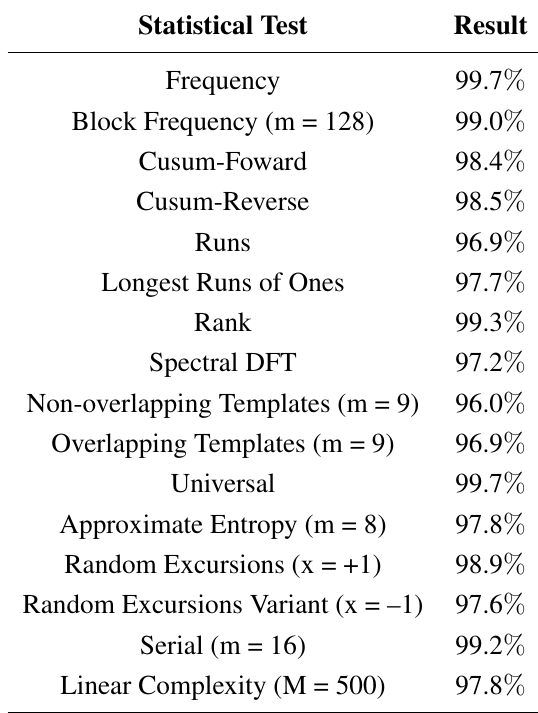
Table 3. Result of NIST randomness